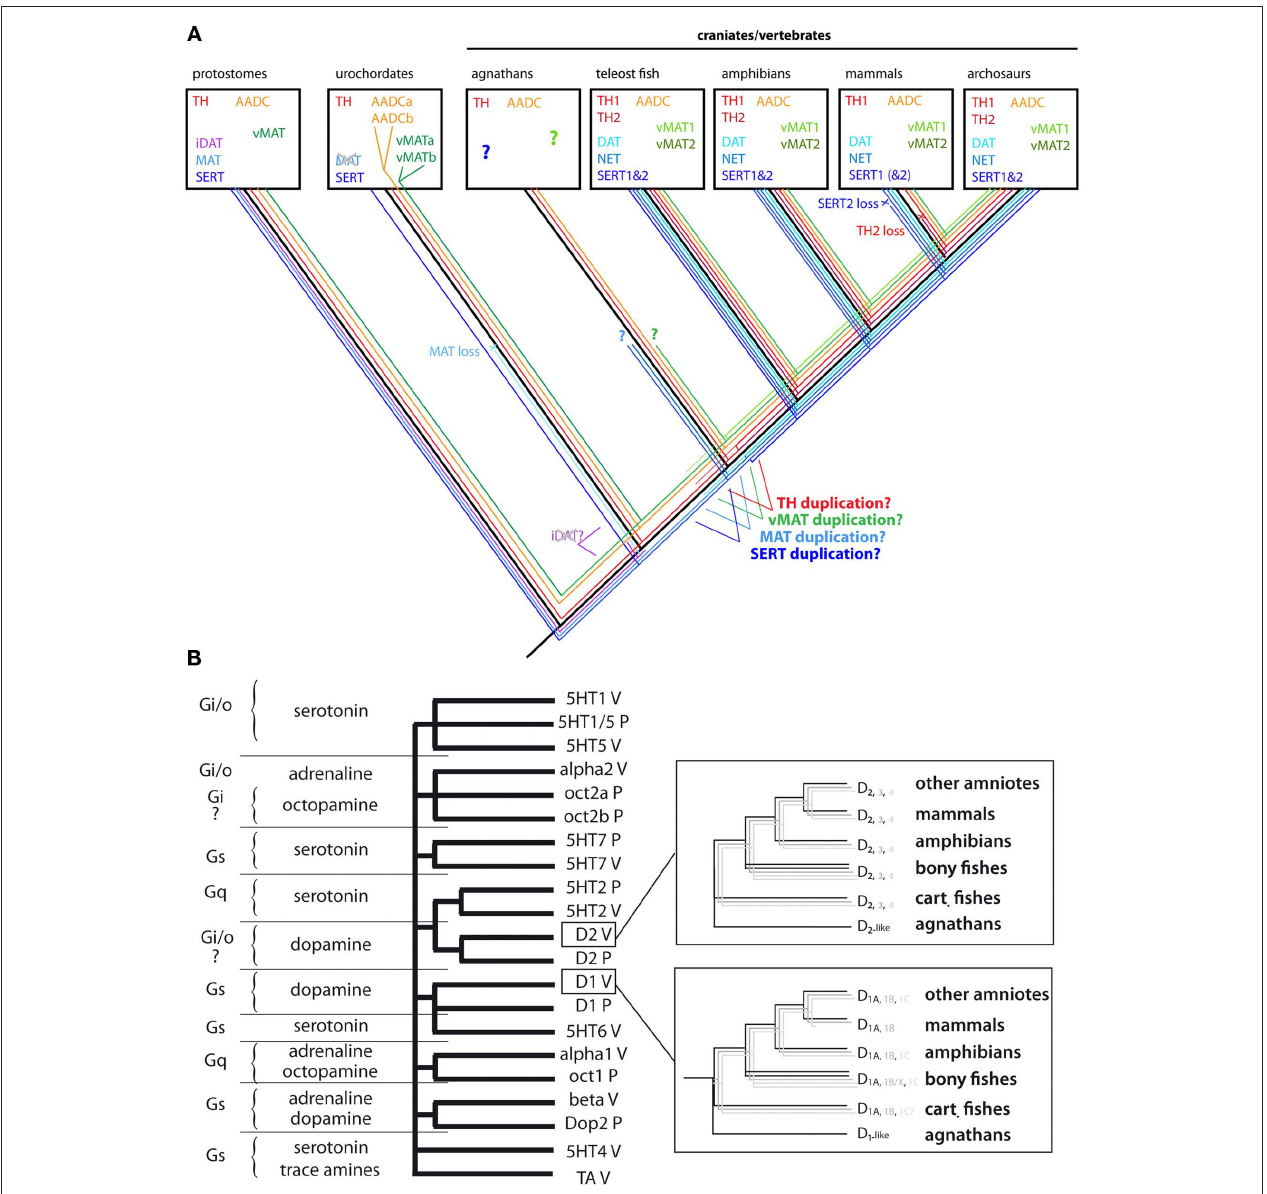
vMAT, vesicular monoamine transporter (green). (B) The molecular phylogeny of monoamine receptor in bilaterian animals reveals that most classes of monoamine receptors predated the origin of chordates and vertebrates. Classes of orthologous receptors in vertebrates and protostomes (most sequences come from ecdysozoan insects and nematodes) are transducing signals in cells via the same G protein (question marks correspond to the cases when the nature of G protein in not known), highlighting one of the major constraint on the conservation of the receptor sequences throughout bilaterian evolution. For example, α 1 adrenergic receptors are orthologous to octopamine 1 receptors (Oct1) and α 2 adrenergic receptors are orthologous to octopamine 2 receptors (Oct2), but both D -like and D -like receptors are also dopaminergic in protostomes. The topology 1 2 of the tree also shows that receptor classes that bind the same natural ligand (e.g., DA) are not grouped together, suggesting that each class of receptor acquired independently and convergently the ability to bind a given neurotransmitter. Inside the rectangle, a simplified version of the phylogenetical relationships of the D and D receptor is presented. Three subtypes of receptor 1 2 exist in each class, with the notable exception